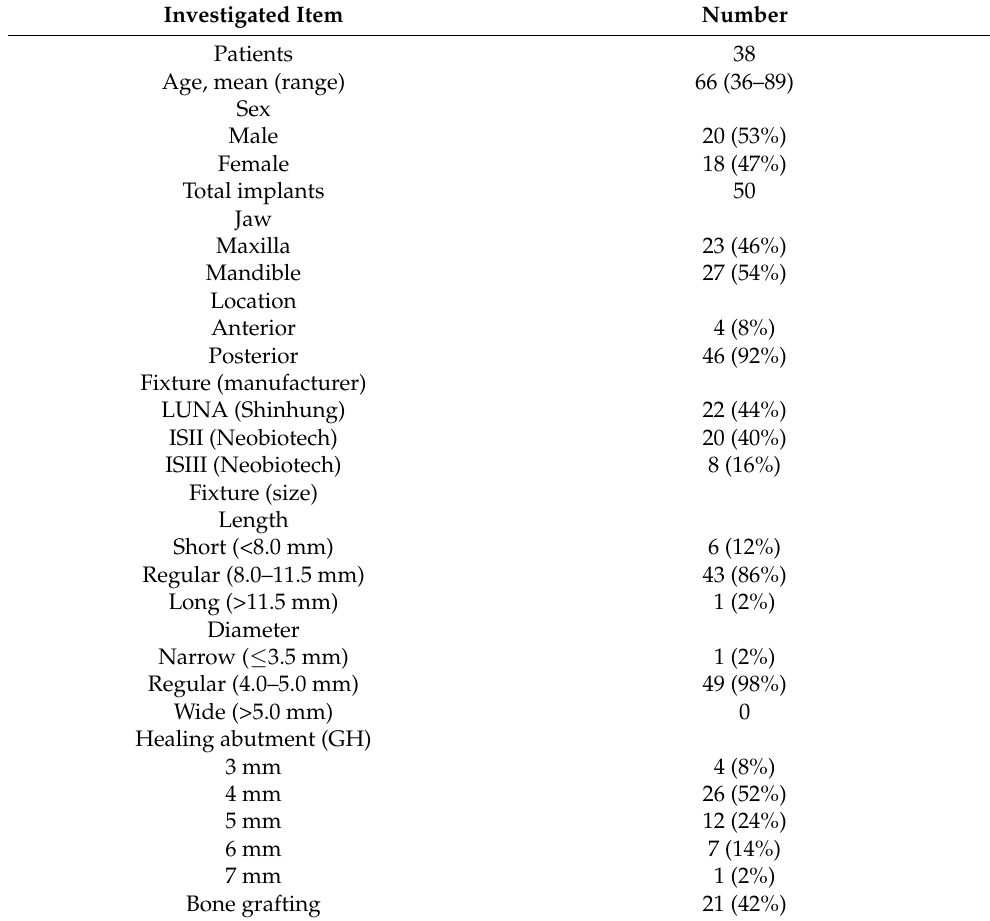
Table 1. Demographic data of the patients and characteristics of the dental